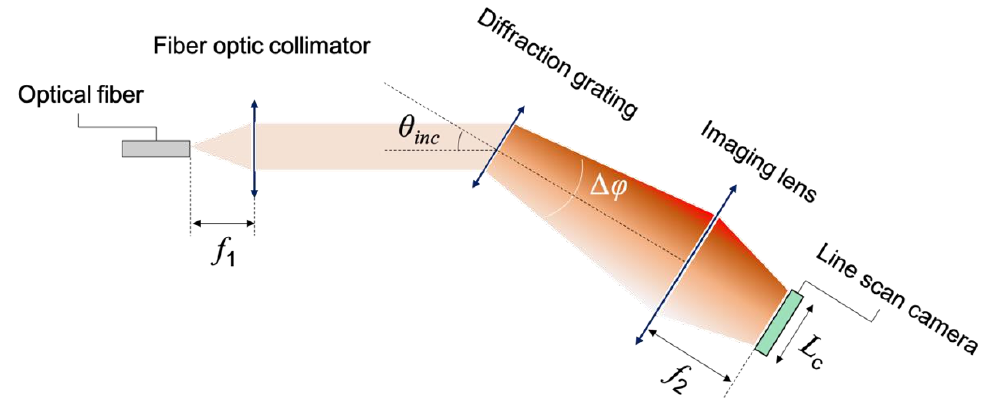
Figure 1. Spectrometer design parameters. The focal length of the fiber-optic collimator is f 1 , the incident angle to the transmission gratings is θ inc , the di ff racted divergence angle is ∆ ϕ , the focal length of the imaging lens is f 2 , and the length of the line-scan camera (LSC) is L c .